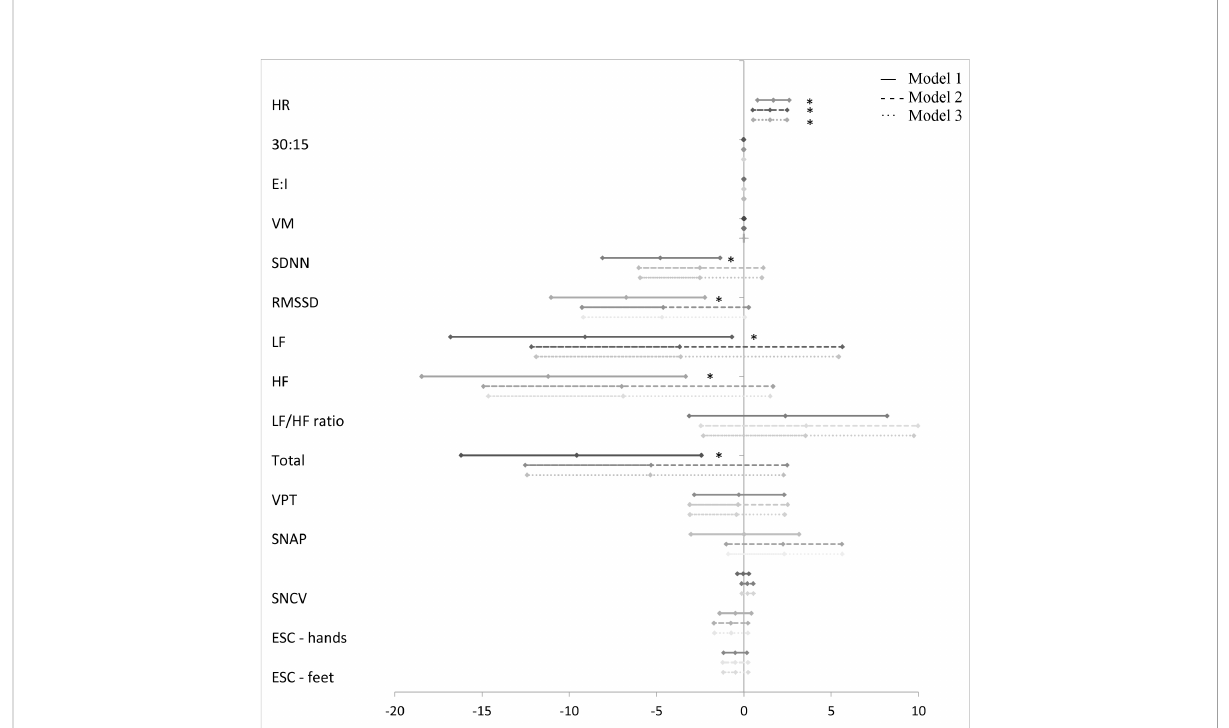
FIGURE 5 Forest plot of the associations between “ oxidative stress ” and measures of diabetic neuropathy. Results are presented as estimates and 95% con fi dence intervals. Estimates show the percentage change in the outcomes for an increase of one unit of “ oxidative stress ” . Studies with con fi dence interval crossing the vertical line are inconclusive. Model 1 adjusted for age and gender, model 2 adjusted as model 1 + diabetes duration and HbA 1c , and model 3 adjusted as model 2 + current smoking, total cholesterol, triglycerides, systolic blood pressure, and the use of beta blockers. CAN, cardiovascular autonomic neuropathy; HR, heart rate; 30:15, lying-to-standing test; E:I, deep breathing test; VM, Valsalva Manoeuvre; SDNN, standard deviation of normal-to-normal intervals; RMSSD, root mean square of the sum of the squares of differences between consecutive R-R intervals; LF, low-frequency power; HF, high-frequency power; DSPN, distal symmetric polyneuropathy; VPT, vibration perception threshold; SNAP, sural nerve amplitude potential; SNCV, sural nerve conduction velocity; ESC, electrochemical skin conduction. *p <